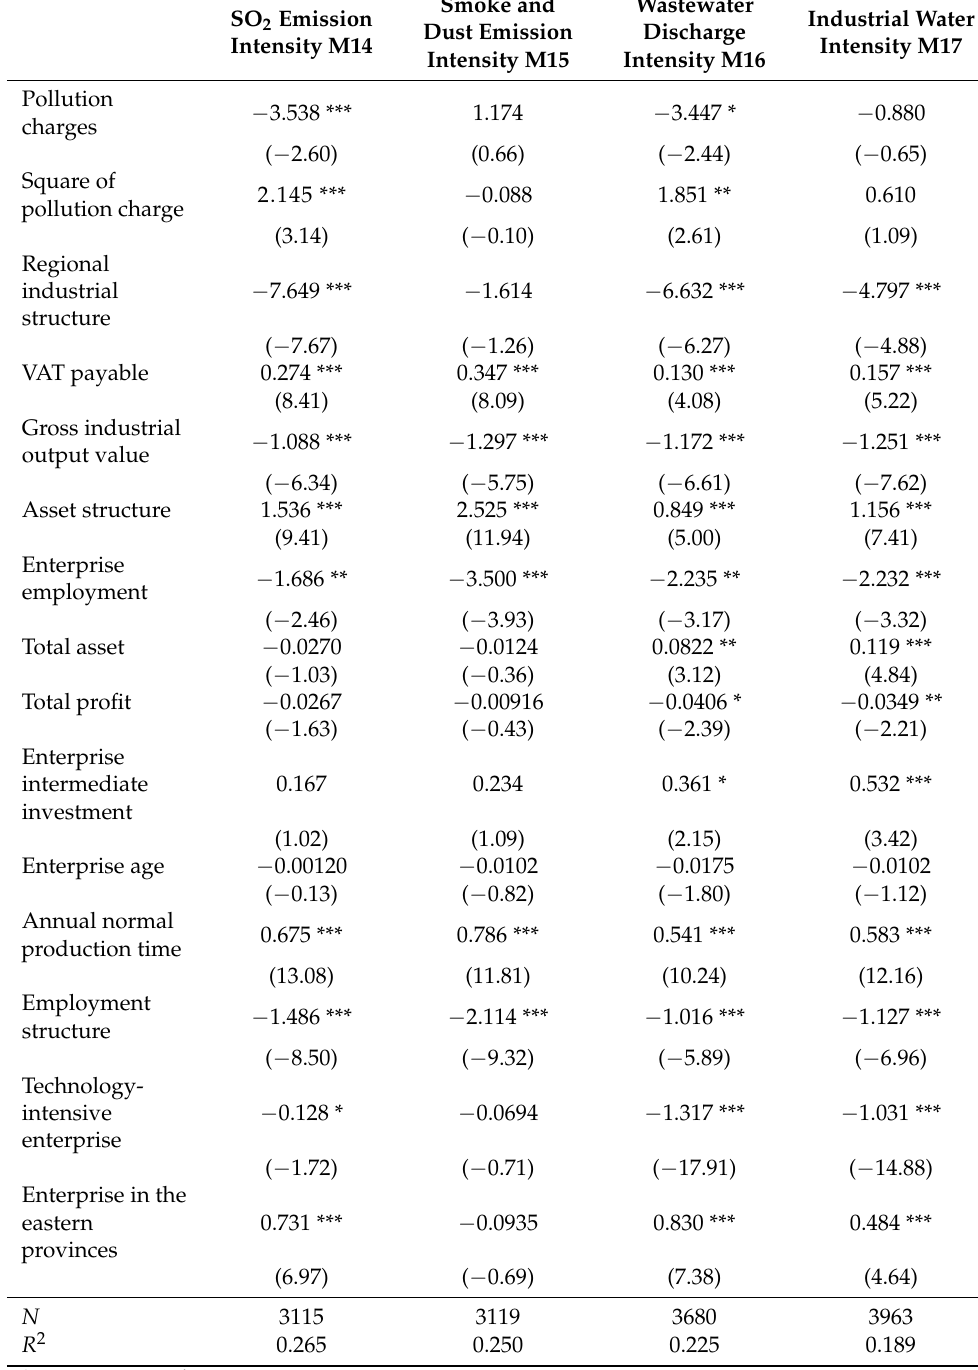
Table 6. Regression results of the impact of pollution charges on enterprises’ process improvement and technological innovation in